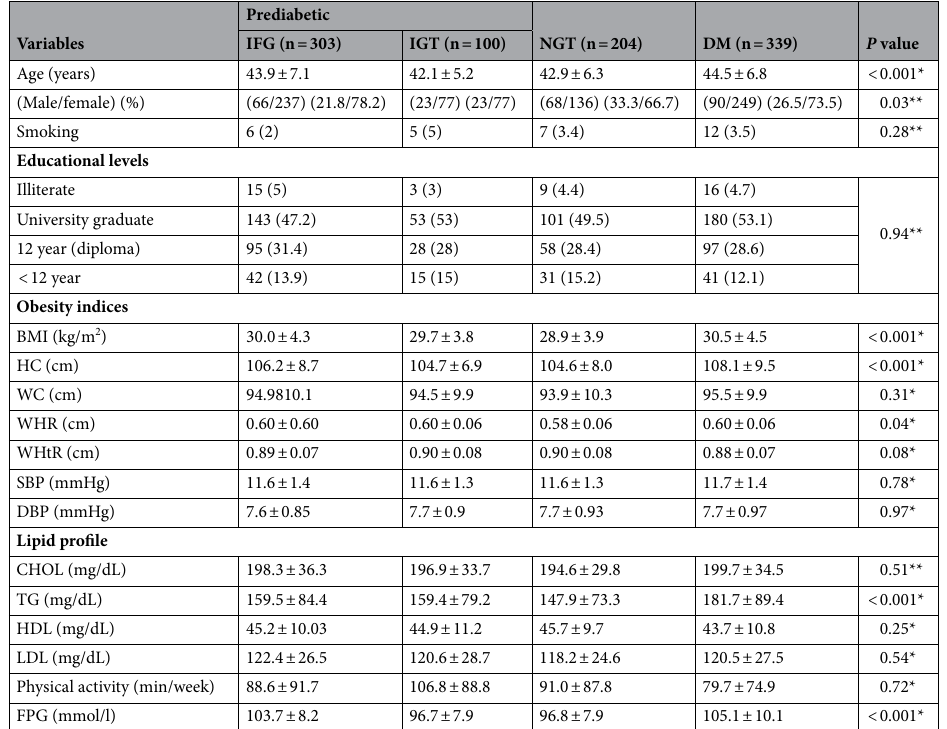
Table 2. Basic demographic and clinical characteristics of different categories of subjects at the end of follow-up. Values are mean ± SD for continuous and frequency (%) for categorical variables. IGT impaired glucose tolerance, IFG impaired fasting glucose, NGT normal glucose tolerance, DM diabetes group, BMI Body mass index, HC hip circumference, WC waist circumference, WHR waist to hip ratio, WHtR waist to height ratio, SBP systolic blood pressure, DBP diastolic blood pressure, CHOL total cholesterol, TG triglycerides, HDL high-density lipoprotein cholesterol, LDL low-density lipoprotein cholesterol, FPG fasting plasma glucose. *ANOVA test, **Chi-square test, P < 0.05 is considered as